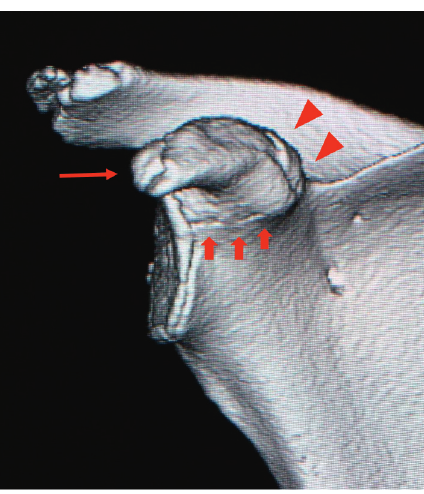
Figure 5: Representative three-dimensional computed tomogra- phy image of a normal epiphyseal line around the coracoid of an 11-year-old girl. A normal coronoid process has three epiphyseal lines: the base (broad arrows), center (triangular arrows), and tip (narrow